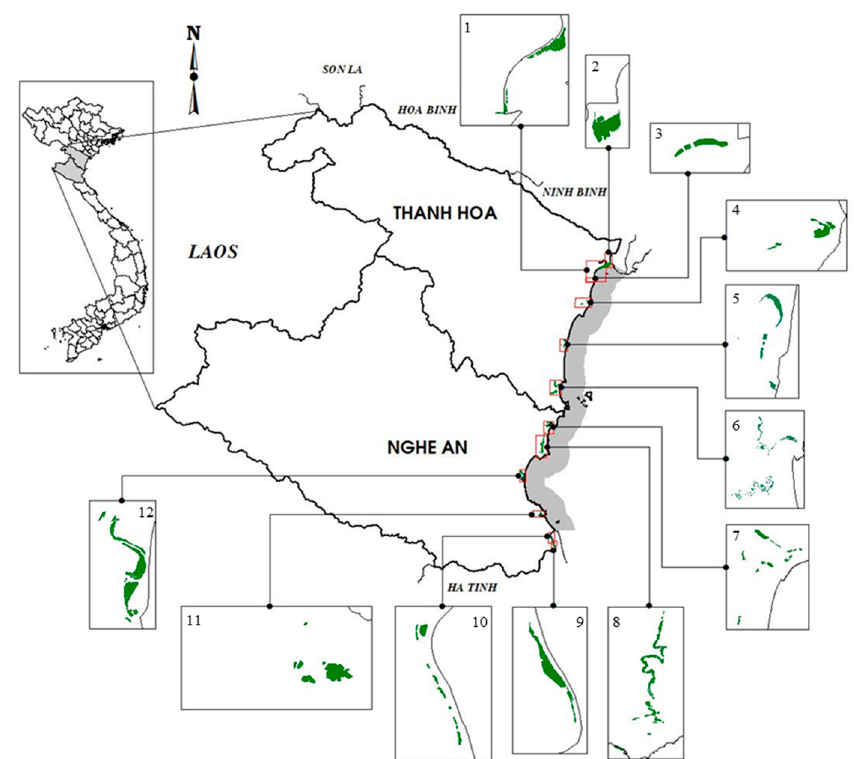
Figure 1. Location map of the study areas showing the distribution of the mangroves in green in